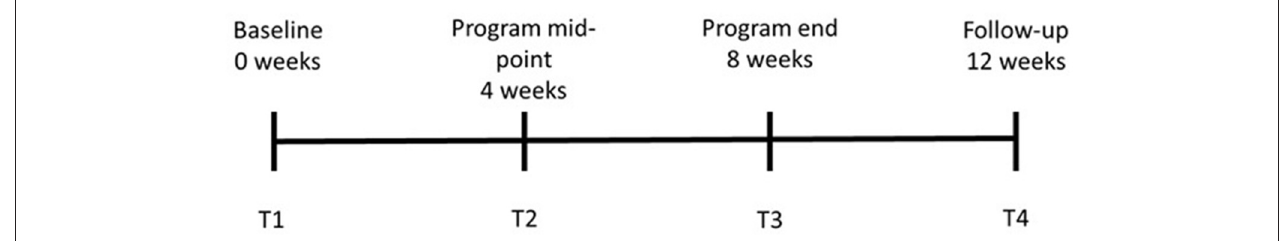
FIGURE 1 | Program lifespan and critical